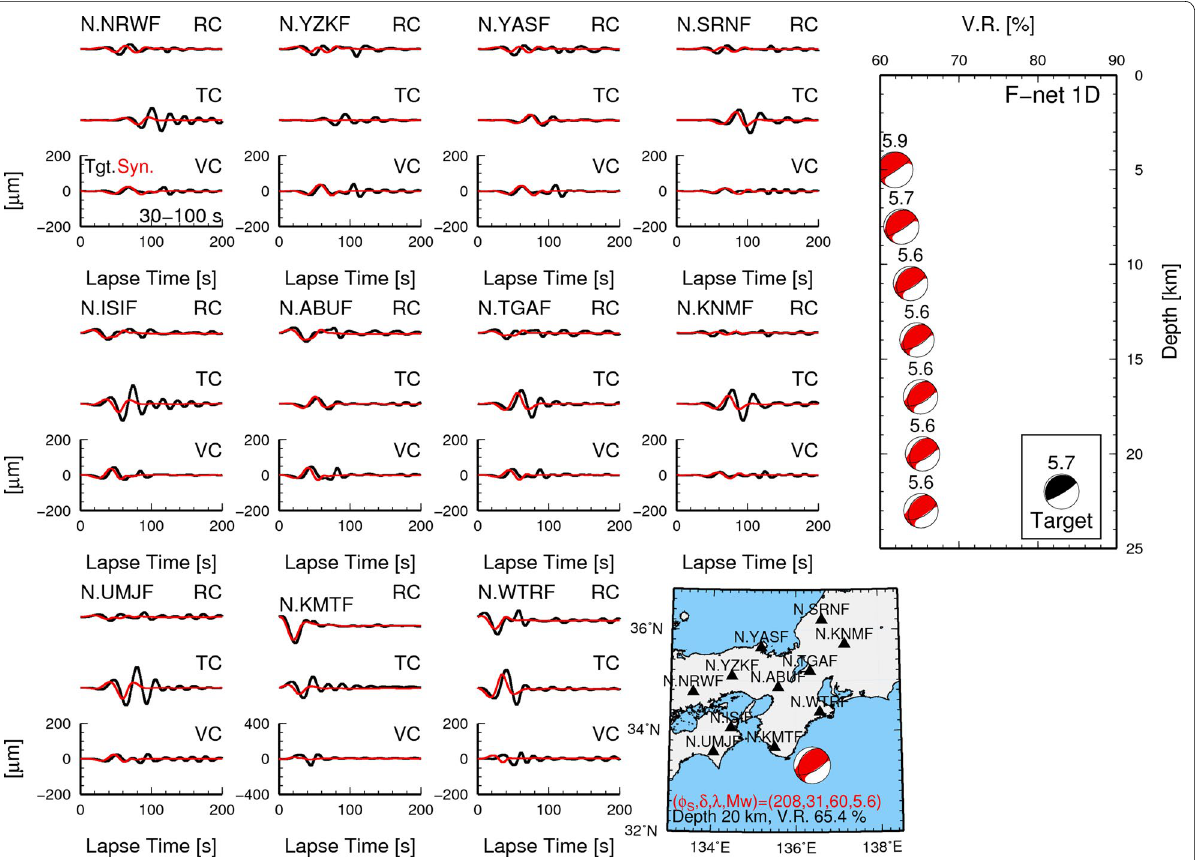
Fig. 6 MT inversion of the test earthquake using the F-net 1D velocity structure model. Depth variation of the variance reduction (V.R.) is shown in the right subfigure. The number above each focal sphere is the estimated Mw at each depth. Black and red traces are the target and synthetic displacement waveforms for periods of 30–100 s at 11 F-net stations, respectively. The focal sphere of the target earthquake is shown in the right- bottom corner of the right